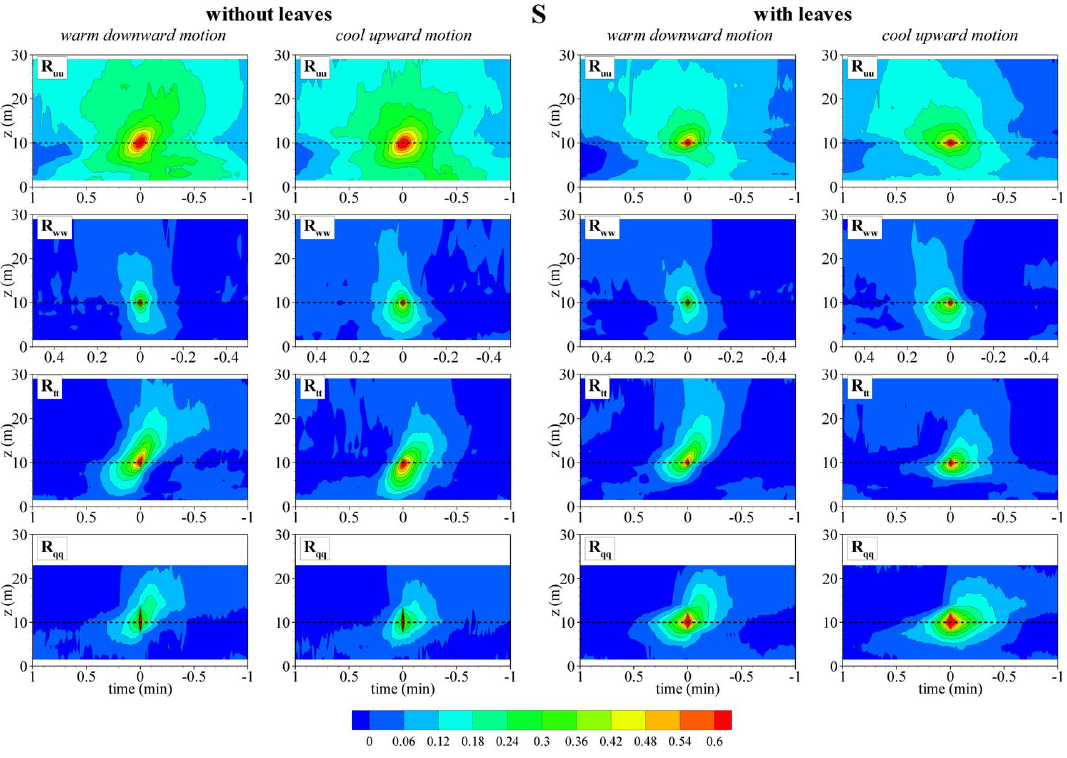
Fig. 10. Autocorrelation contours of u ( R uu ), w ( R ww ), t ( R tt ) and q ( R qq ) associated with warm downward and cool upward motions referenced to canopy top ( Z = 10m) and T = 0min, for the stable regime (S) and for both seasonal periods. The autocorrelations correspond | 1 4 | 1 to R 2 ϕϕ and R ϕϕ in Eq. (10), where ϕ is either u , w , t or q . Negative times correspond to times before the structure detection (downwind condition) and positive times to times after the structure detection (upwind condition). The dashed line indicates the canopy